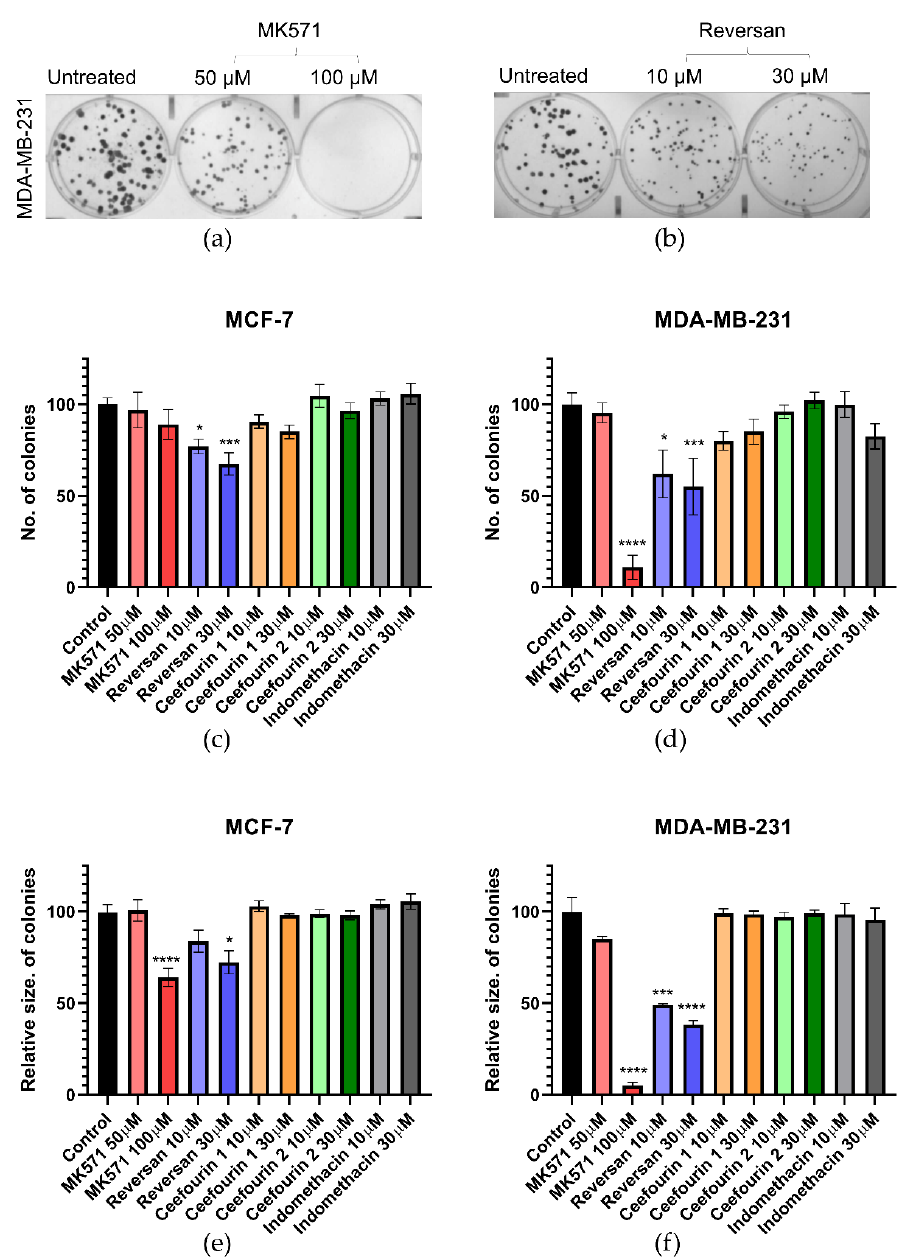
Figure 2. MK571 and Reversan affect the clonogenic capacity of breast cancer cells. 100 cells/well were seeded in 6-well plates and cultured at 37 °C for 24 h, after which cells were treated with the indicated concentrations of inhibitors. Control wells were untreated cells. After 7 days of culture, the colonies formed were fixed with 4% paraformaldehyde and stained with 0.1% crystal violet, the colonies counted and measured. Example results for MDA-MB-231 cells treated with ( a ) MK571 or ( b ) Reversan. Average results for the number ( c , d ) and size ( e , f ) of colonies for MCF-7 cells ( c , e ) and MDA-MB-231 ( d , f ). Data are mean ± sem, n ≥ 6. Data were analyzed using a one-way ANOVA with a Dunnett’s post hoc test; * p < 0.05, *** p < 0.001, and **** p < 0.0001 significantly lower than the untreated